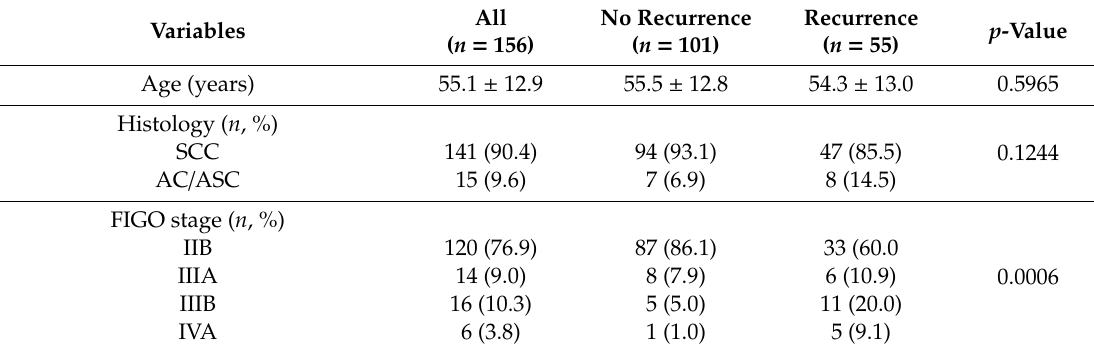
Table 1. Clinicopathologic characteristics and PET metabolic parameters of patients with and without